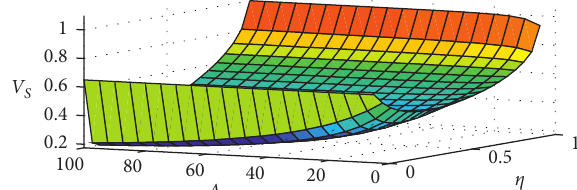
S of the two-mode cavity